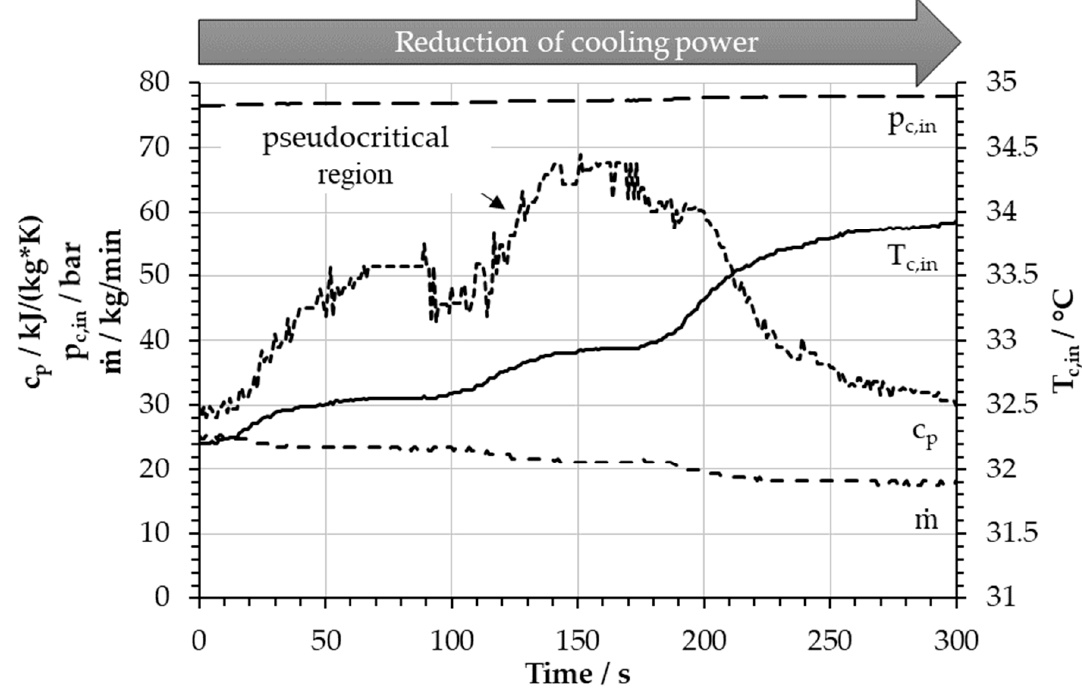
Figure 4. Measurements at the compressor inlet while crossing the pseudocritical line during reduction of cooling power at constant compressor rotational speed.